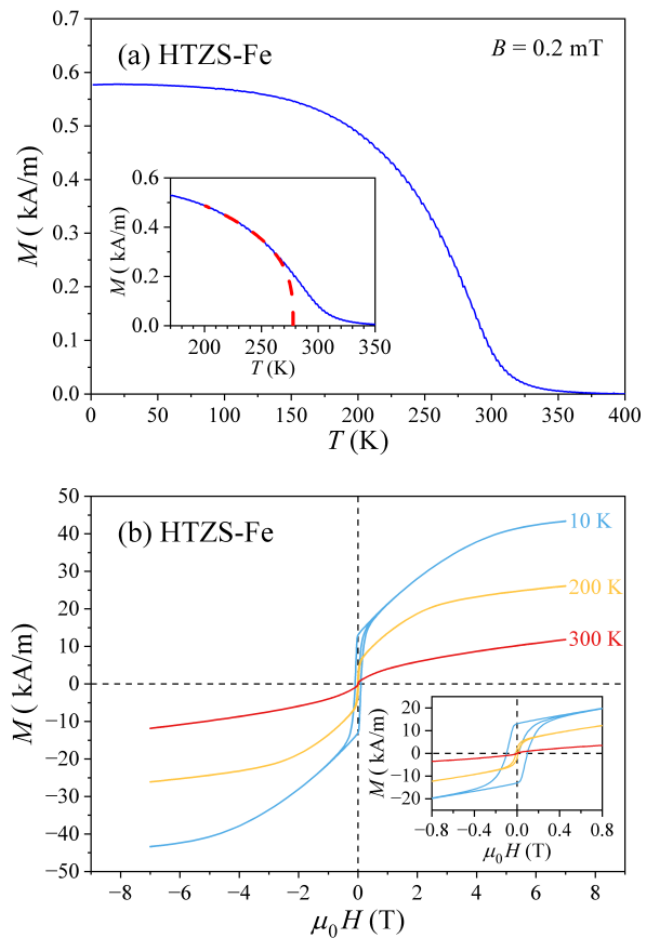
Figure 10a), which yielded the FM transition temperature T FM ≈ 278 K and the critical exponent β = 0.32. The M ( H ) curves at the selected temperatures of 300, 200, and 10 K are presented in Figure 10b.